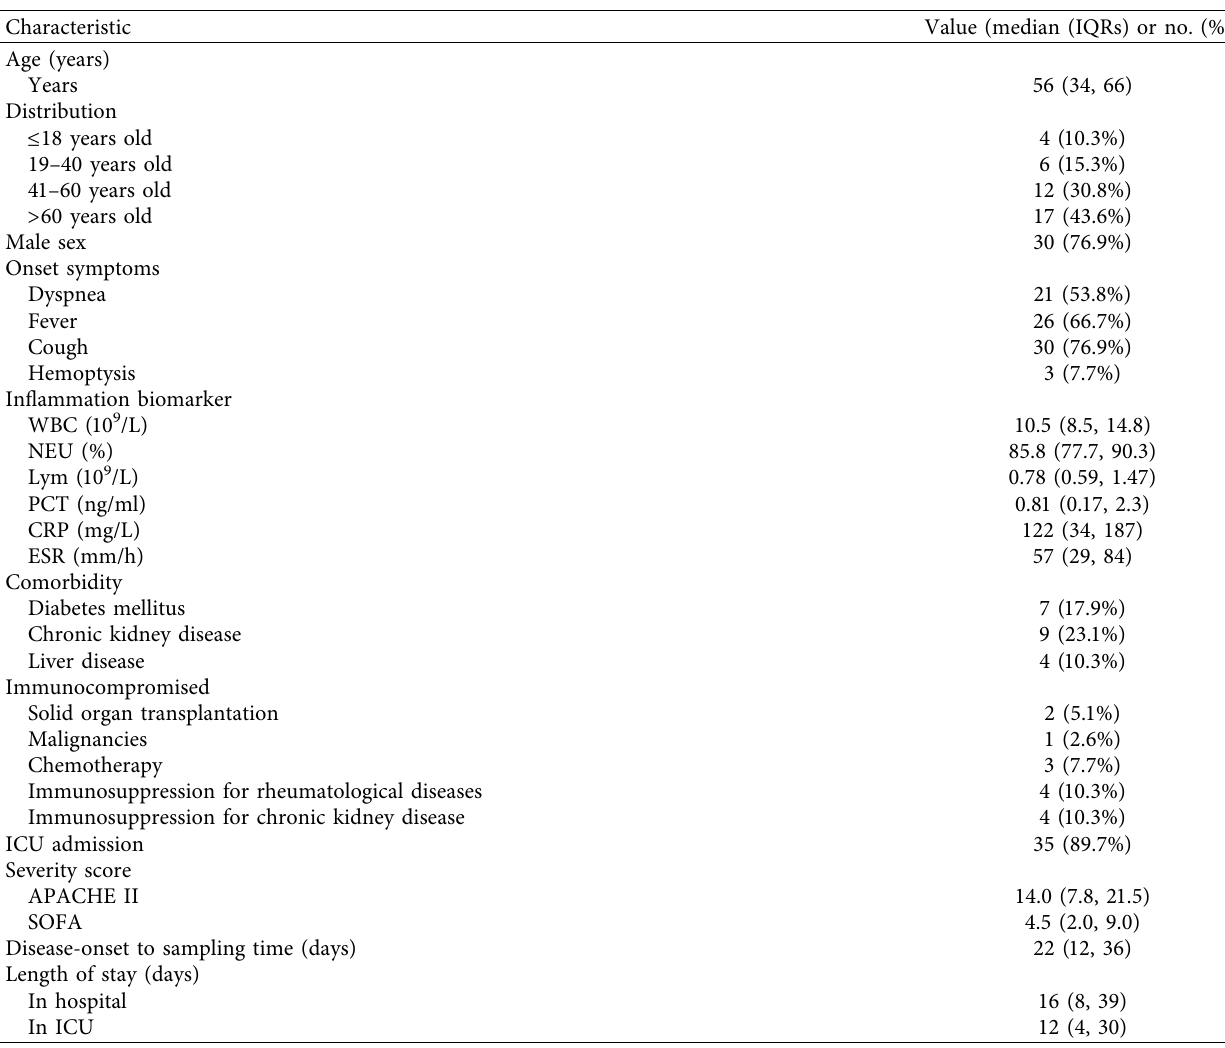
Table 1: Baseline characteristics of 39